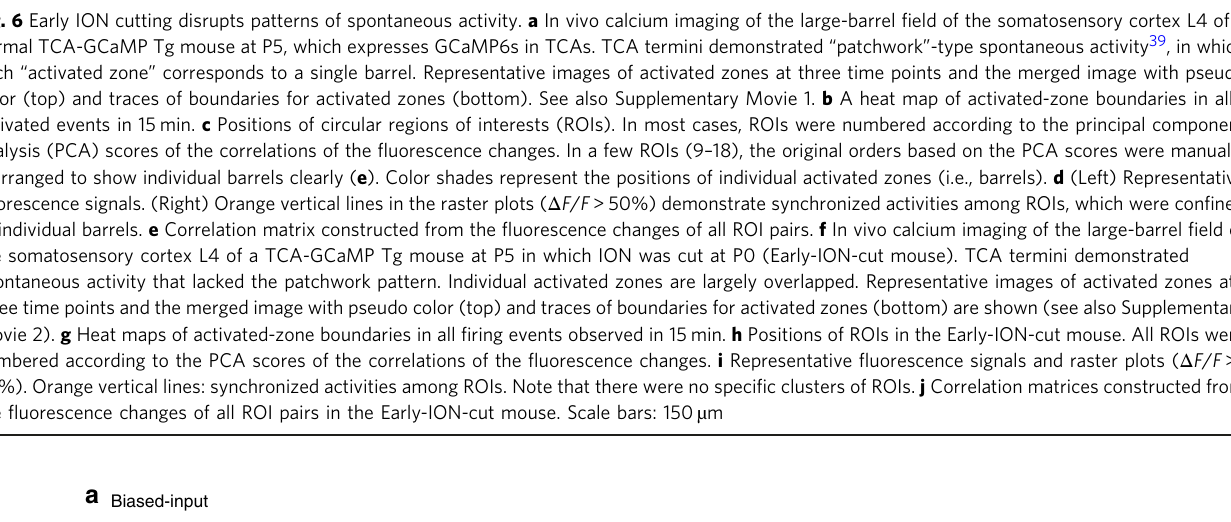
Fig. 6 Early ION cutting disrupts patterns of spontaneous activity. a In vivo calcium imaging of the large-barrel fi eld of the somatosensory cortex L4 of a normal TCA-GCaMP Tg mouse at P5, which expresses GCaMP6s in TCAs. TCA termini demonstrated “ patchwork ” -type spontaneous activity 39 , in which each “ activated zone ” corresponds to a single barrel. Representative images of activated zones at three time points and the merged image with pseudo color (top) and traces of boundaries for activated zones (bottom). See also Supplementary Movie 1. b A heat map of activated-zone boundaries in all activated events in 15 min. c Positions of circular regions of interests (ROIs). In most cases, ROIs were numbered according to the principal component analysis (PCA) scores of the correlations of the fl uorescence changes. In a few ROIs (9 – 18), the original orders based on the PCA scores were manually rearranged to show individual barrels clearly ( e ). Color shades represent the positions of individual activated zones (i.e., barrels). d (Left) Representative fl uorescence signals. (Right) Orange vertical lines in the raster plots ( Δ F / F > 50%) demonstrate synchronized activities among ROIs, which were con fi ned to individual barrels. e Correlation matrix constructed from the fl uorescence changes of all ROI pairs. f In vivo calcium imaging of the large-barrel fi eld of the somatosensory cortex L4 of a TCA-GCaMP Tg mouse at P5 in which ION was cut at P0 (Early-ION-cut mouse). TCA termini demonstrated spontaneous activity that lacked the patchwork pattern. Individual activated zones are largely overlapped. Representative images of activated zones at three time points and the merged image with pseudo color (top) and traces of boundaries for activated zones (bottom) are shown (see also Supplementary Movie 2). g Heat maps of activated-zone boundaries in all fi ring events observed in 15 min. h Positions of ROIs in the Early-ION-cut mouse. All ROIs were numbered according to the PCA scores of the correlations of the fl uorescence changes. i Representative fl uorescence signals and raster plots ( Δ F / F > 50%). Orange vertical lines: synchronized activities among ROIs. Note that there were no speci fi c clusters of ROIs. j Correlation matrices constructed from the fl uorescence changes of all ROI pairs in the Early-ION-cut mouse. Scale bars: 150 µ